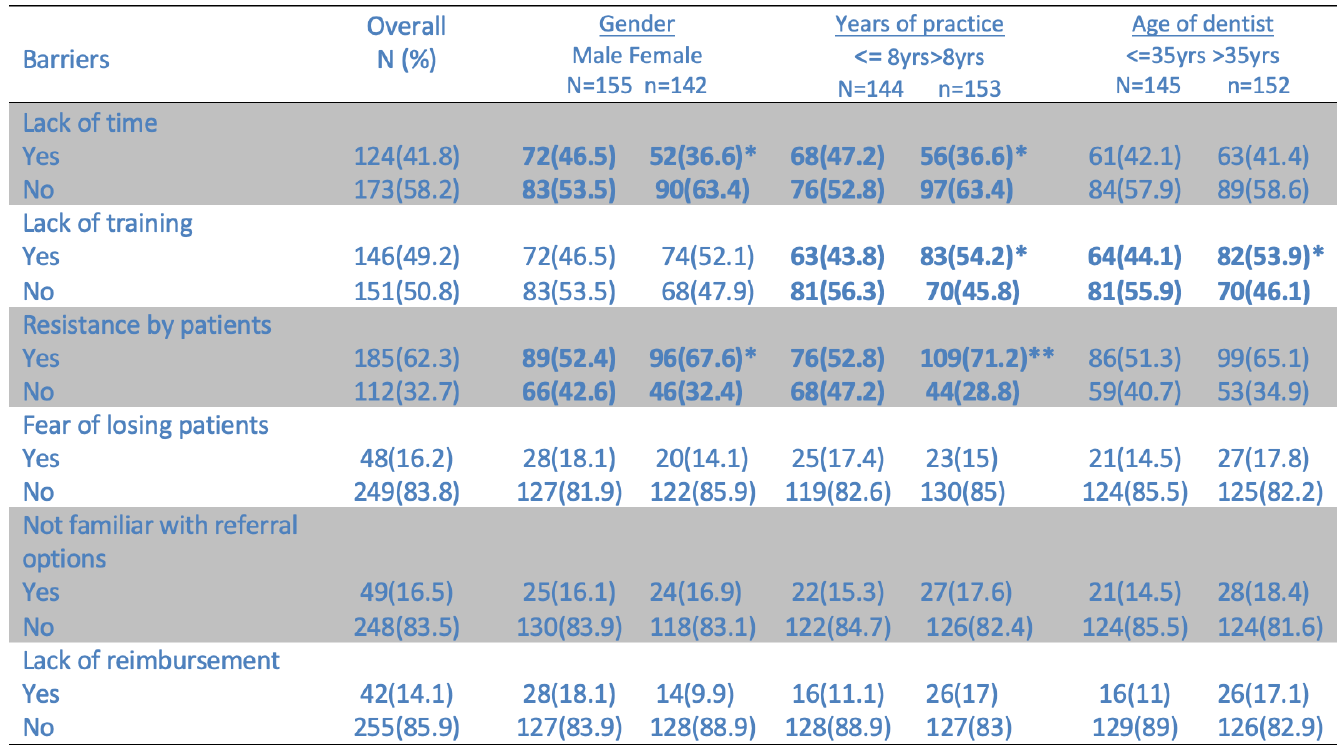
Table 5. Barriers perceived by parDcipaDng denDsts in providing TCI to their